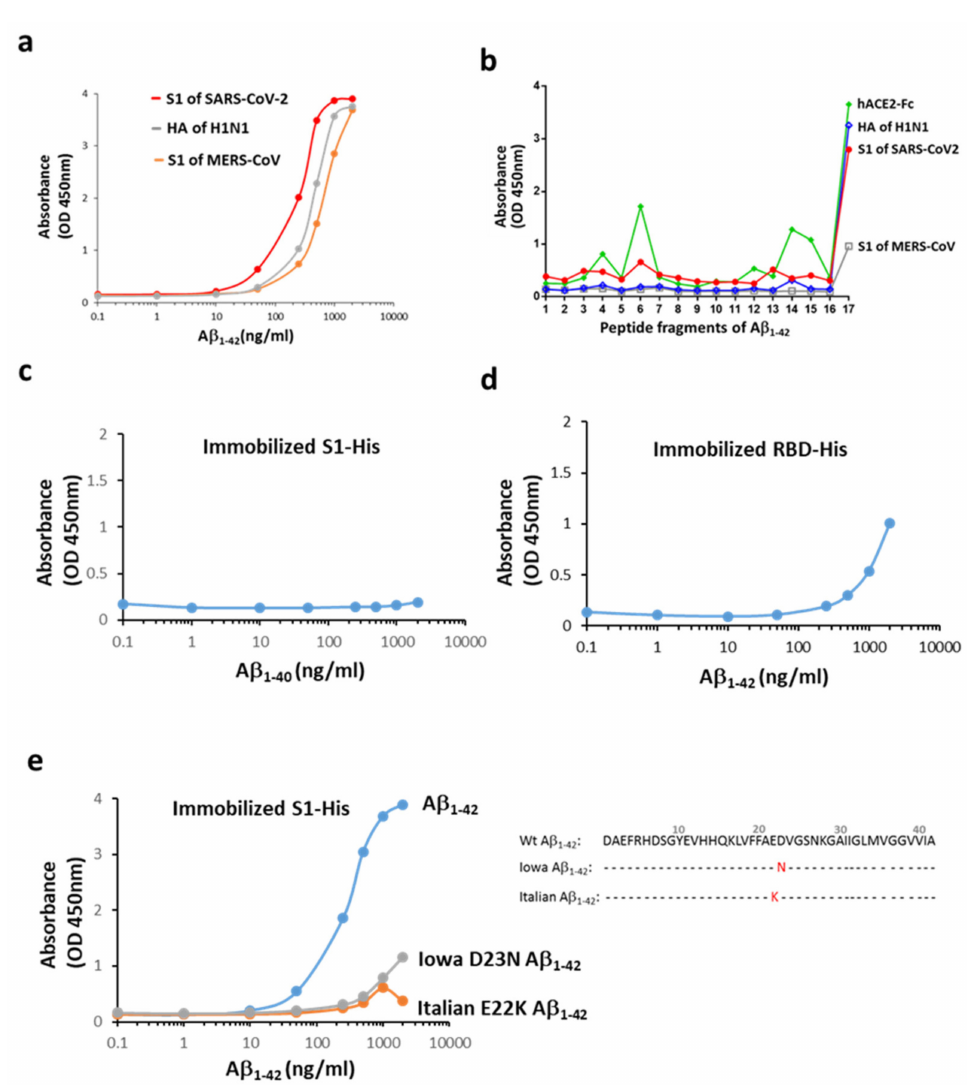
Figure 1. Interactions between A β 1-42 and the S1 of SARS-CoV-2. ( a ) A β 1-42 differentially binds to the immobilized surface proteins of three viruses responsible for recent pandemics. The order of potency of binding based on the estimated EC 50 was the S1 of SARS-CoV-2 (200–325 ng/mL) > HA of H1N1 (HA, 372–507 ng/mL) > S1 of MERS-CoV (599–860 ng/mL). ( b ) Linear epitope mapping was performed using 17 fragment peptides of A β 1-42 (details in Supplementary Figure S2), and the binding ability is indicated by OD. A β 1-42 interacted with the S1 of SARS-CoV-2, mainly in the last probe containing the hydrophobic A β residues of 33–42. A similar binding pattern on A β 1-42 was observed for HA of H1N1, and to a lesser extent, for the S1 of MERS-CoV. hACE2-Fc presents three more binding sites (OD > 0.8) across the entire sequence of A β 1-42 in addition to a major binding site on the C-terminal end. The following binding potency was compared by OD. ( c ) A β 1-40 did not bind to the S1 of SARS-CoV-2. ( d ) A β 1-42 bound weakly to the immobilized His-tagged RBD of SARS-CoV-2 as compared to the S1 protein. ( e ) Iowa D23N and Italian E22K A β 1-42 mutants exerted marked reduction in the S1 binding, and amino acid sequences for normal human (Wt) and mutated A β 1-42 are presented. Data are presented as mean values from two independent